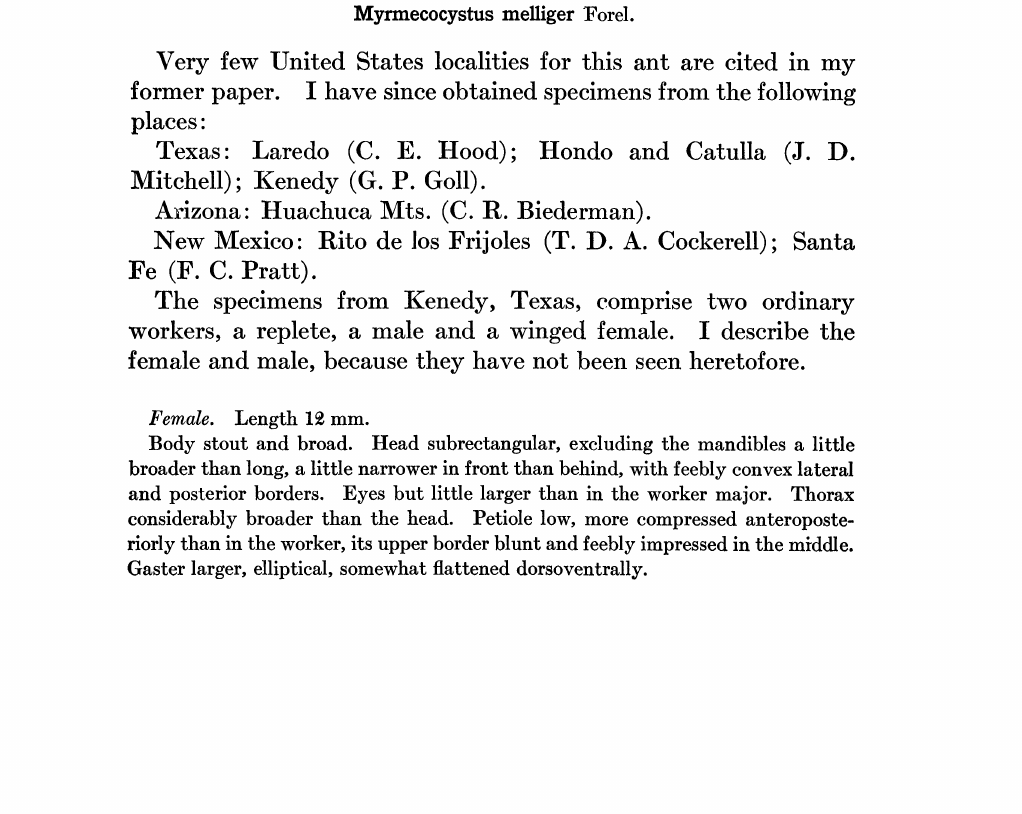
11. Head, thorax, petiole, antennae and legs uniformly deep brownish red melliger mimicus Wheder. Thorax and posterior portion of head usually very dark red or black 12 12. Petiole very blunt and rounded above, scarcely compressed anteroposter- iorly; color of head and thorax variable., melliger mimicus var. jesuita Wheeler. Petiole somewhat more compressed anteroposteriorly; pilosity more abundant; thorax, gaster and posterior portion of head black melliger lomansis subsp, nov. 18. At least the whole head and thorax light yellowish red 14 Head and thorax largely black or dark brown 15 14. Gaster brown, blackish or piceous melliger semirufus Emery. Gaster red, like the head and thorax.., melliger semirufus vat. testaceus Emery. lugubris Wheeler. Most of the body dark brown; head but little longer than broad, gula convex 16 16. Pubescence very short; thorax, gaster and much of the head dark brown; mandibles and anterior border of clypeus and cheeks yellow., yuma sp. nov. Pubescence longer and more silvery; yellow of head extending further posteriorly yuma var. flaviceps var. nov. Myrmecocystus melliger